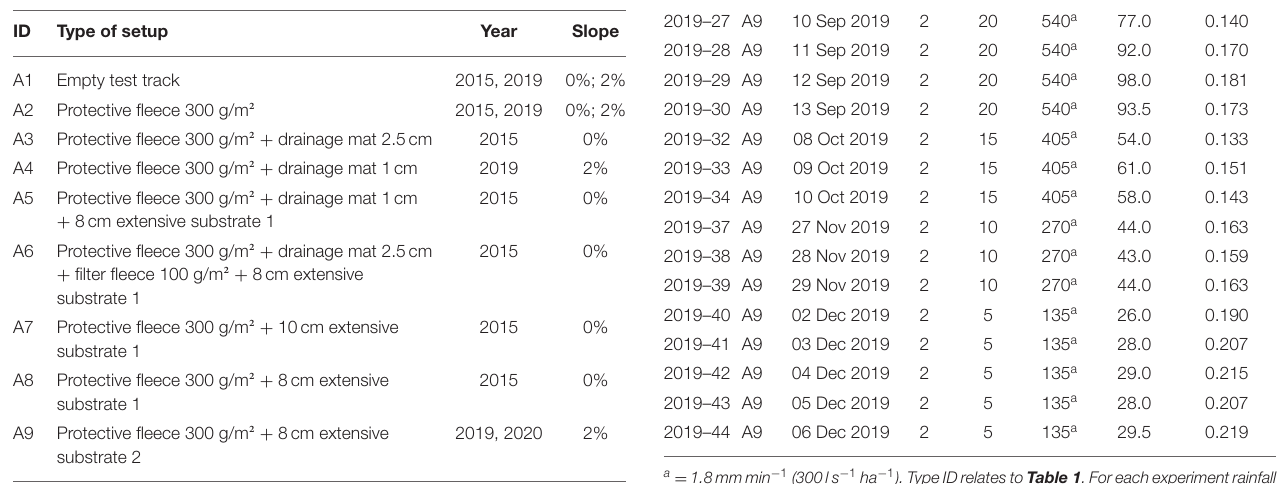
TABLE 1 | Types of setups considered in the artificial rainfall experiments.